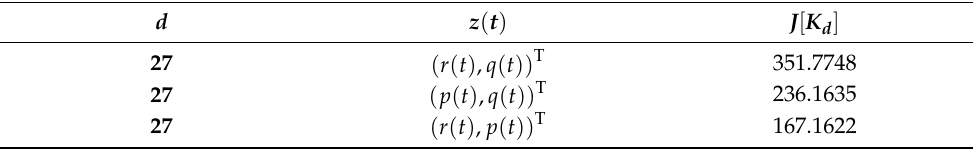
Figure 4. The behavior of the satellite coordinates p , q , r (red) and estimations (blue) for different model of measuring systems: ( a ) z ( t ) = ( r ( t ) , q ( t )) T ; ( b ) z ( t ) = ( p ( t ) , q ( t )) T ; ( c ) z ( t ) = ( r ( t ) , p ( t )) T . Table 4. Solution results for different mini-batch sizes.